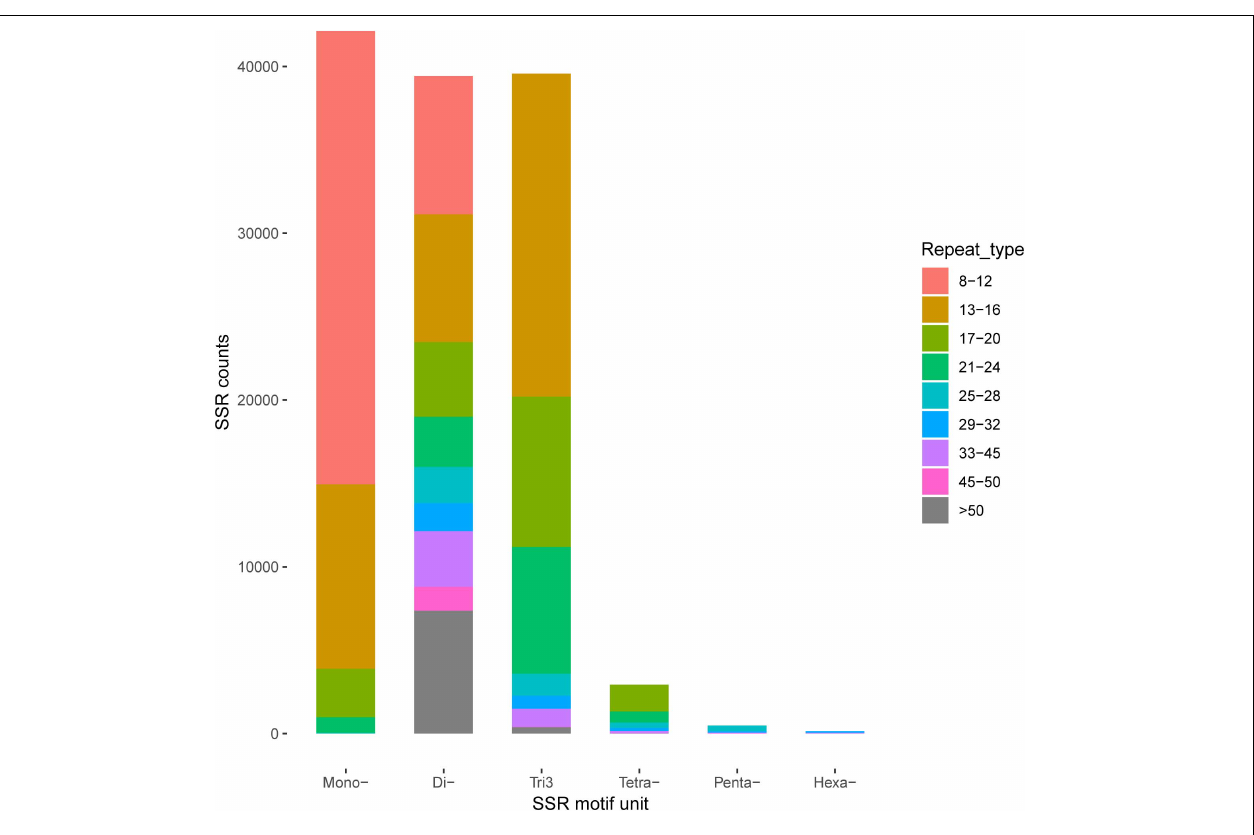
FIGURE 4 | Identification of simple sequence repeats (SSR).